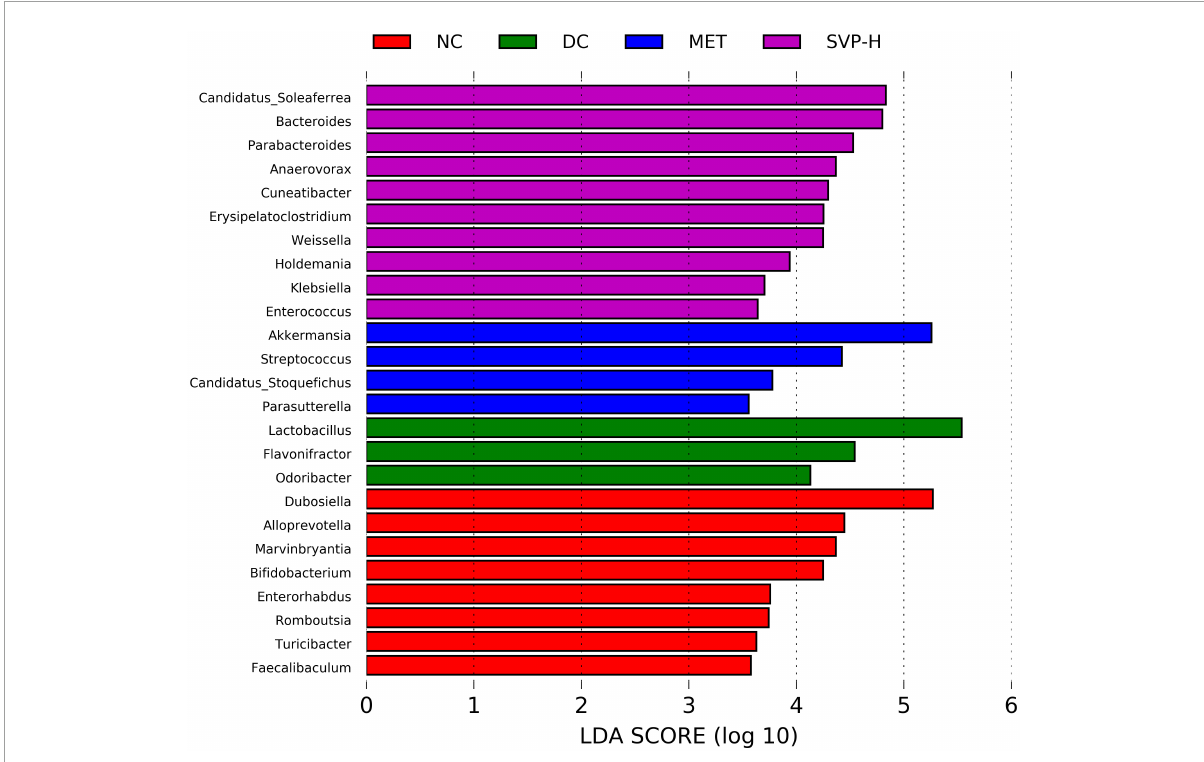
FIGURE8 The characteristic intestinal microbes at genus level among NC, DC, MET, and SVP-H groups conducted by LEfSe analysis. LDA > 3.0, p < 0.05.